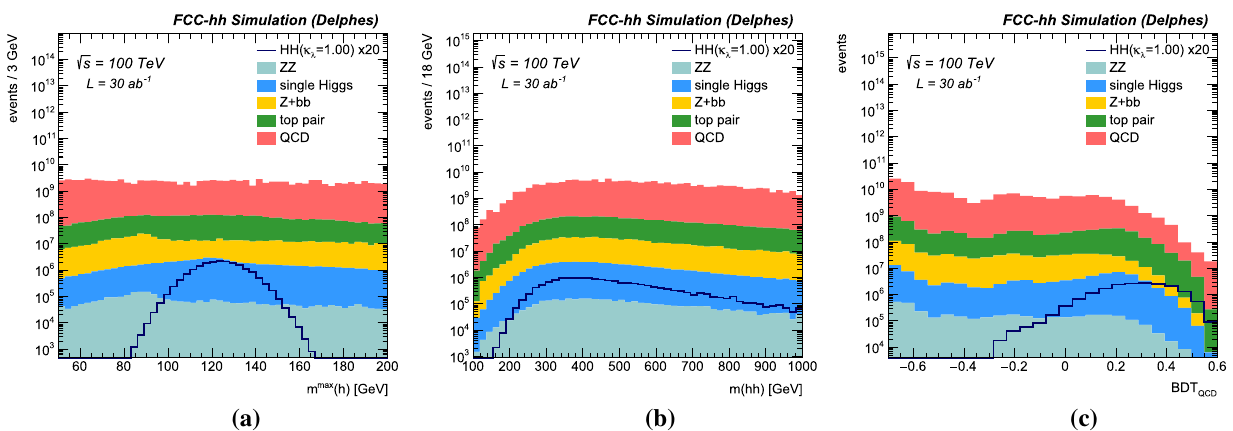
Fig. 11 Distributions in the b ¯ bb ¯ b final state of the highest p T reconstructed Higgs invariant mass (left), the Higgs pair invariant mass (center), and the output of the BDT multi-variate discriminant (right)